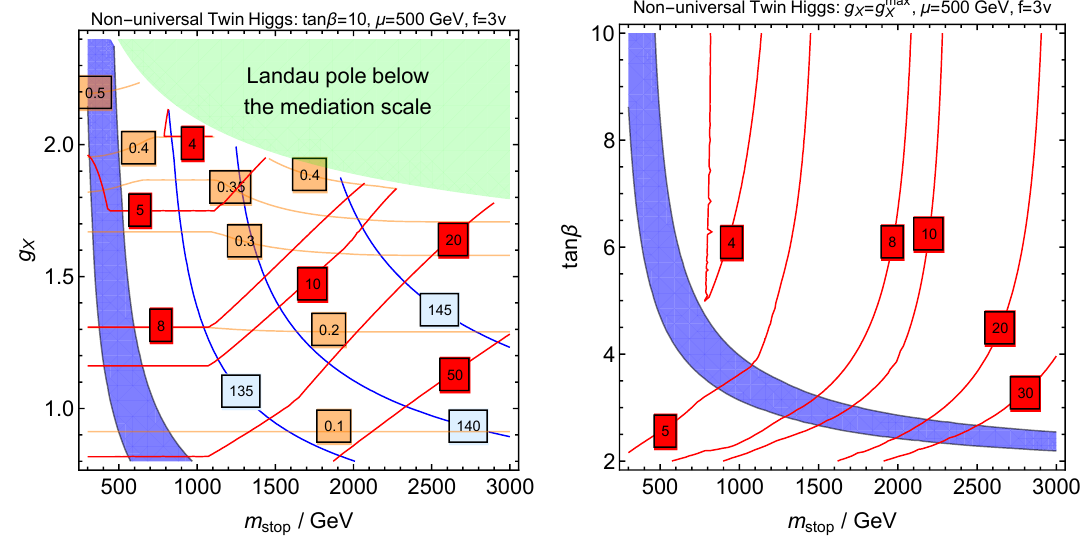
Figure 5 . The same as in (cid:12)gure 4 but for the (cid:13)avor non-universal D -term model with M X = 5 TeV. Similarly as in the case of (cid:12)gure 4, (cid:15) is determined by the requirement that the condition in eq. (4.4) is